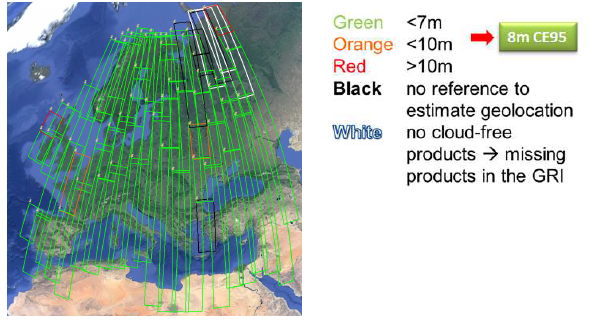
Figure 7. Europe GRI mean geolocation performance.